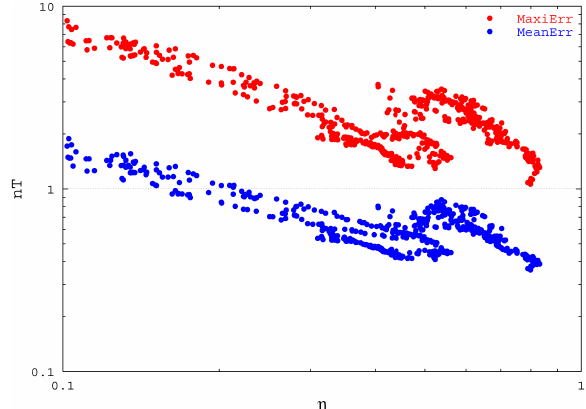
Fig. 2. Magnetic vector evolution (in nT) for the record CLF (6 September 1999): in 3-D frame centered to its mean (left panel), intensity only (right panel).